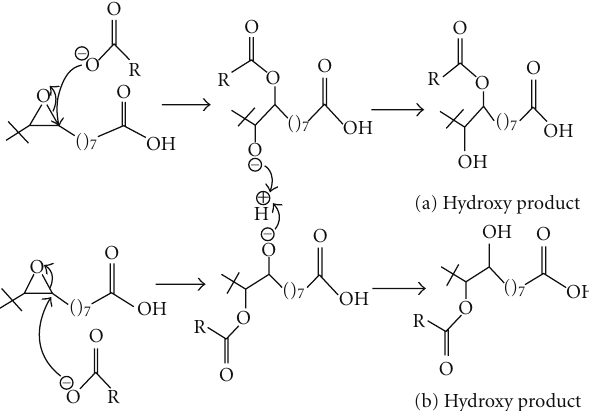
Figure 1: Mechanism for the MEOA ring opening to a ff ord ring opening product, 10 or 13-hydroxy (a); 9 or 12-hydroxy (b).